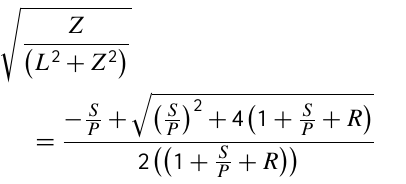
Fig. 6. The relation between lens thickness and lens volume accord- ing to the assumption of an elliptical lens shape (Maas, 2007, his Eq. 5a–c, compare this paper Eq. 16) and the numerical